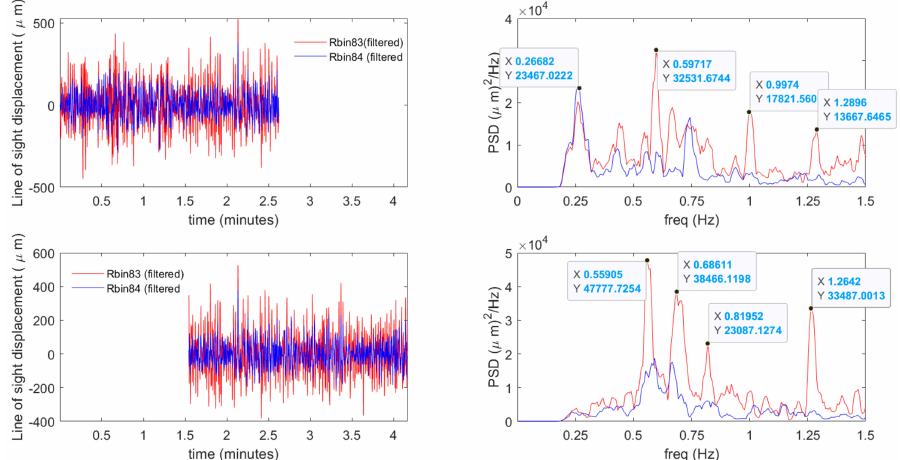
Figure 11. Filtered LOS displacement time histories of bin83 and bin84 with corresponding periodograms spectra calculated for two sub-samples with a partial overlap.